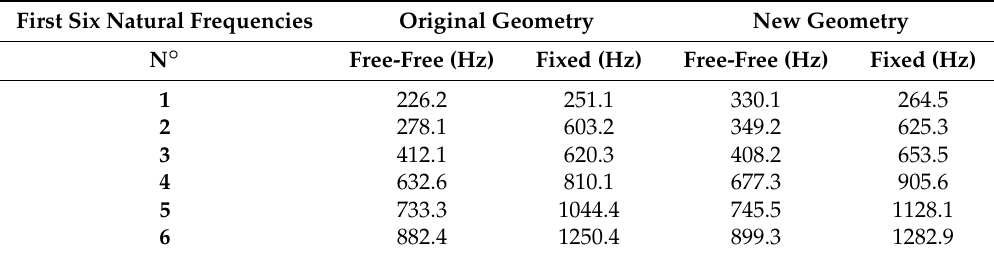
Table 5. Natural frequencies values.